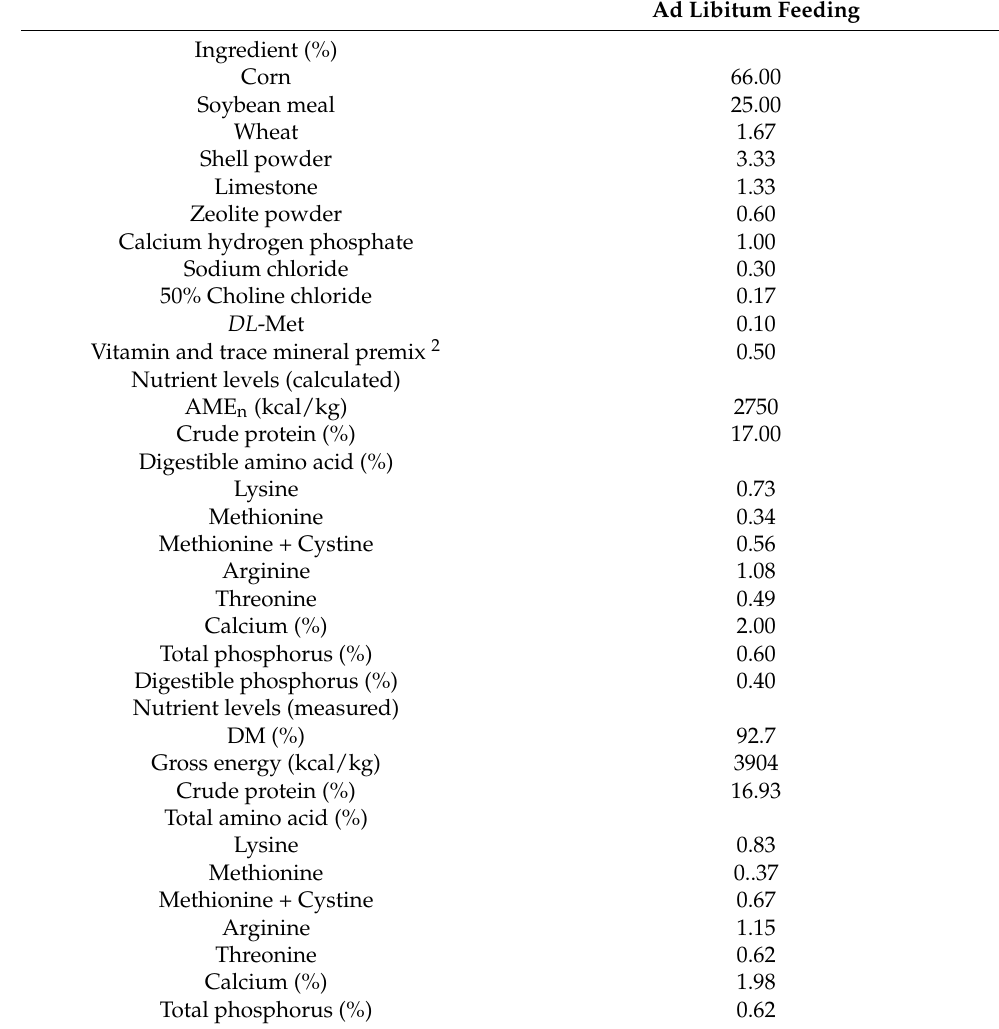
Table 2. Ingredients and nutrient levels of the experimental diet provided from 18 to 21 weeks of age.